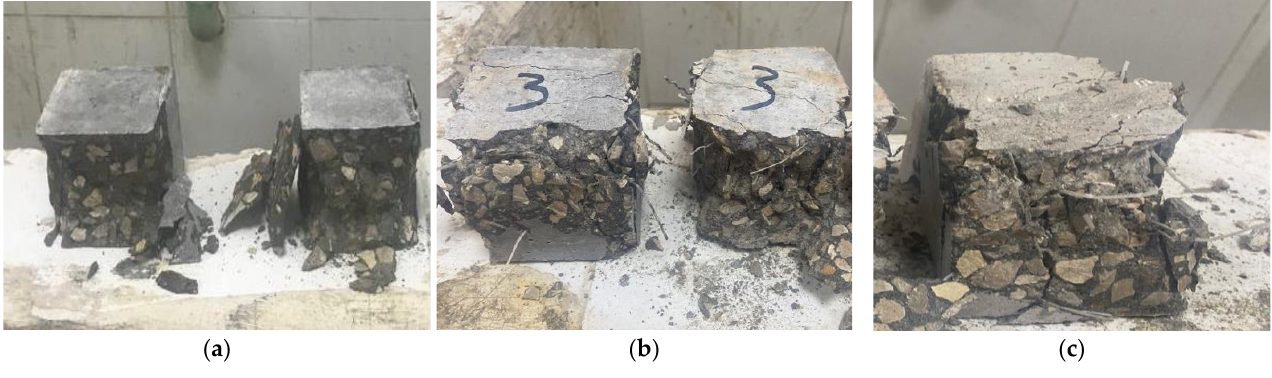
Figure 5. Compressive failure modes for specimens exposed to room temperature for ( a ) Control specimens, ( b ) Hybrid fiber reinforced concrete specimens, ( c ) Mono fiber reinforced concrete specimens.